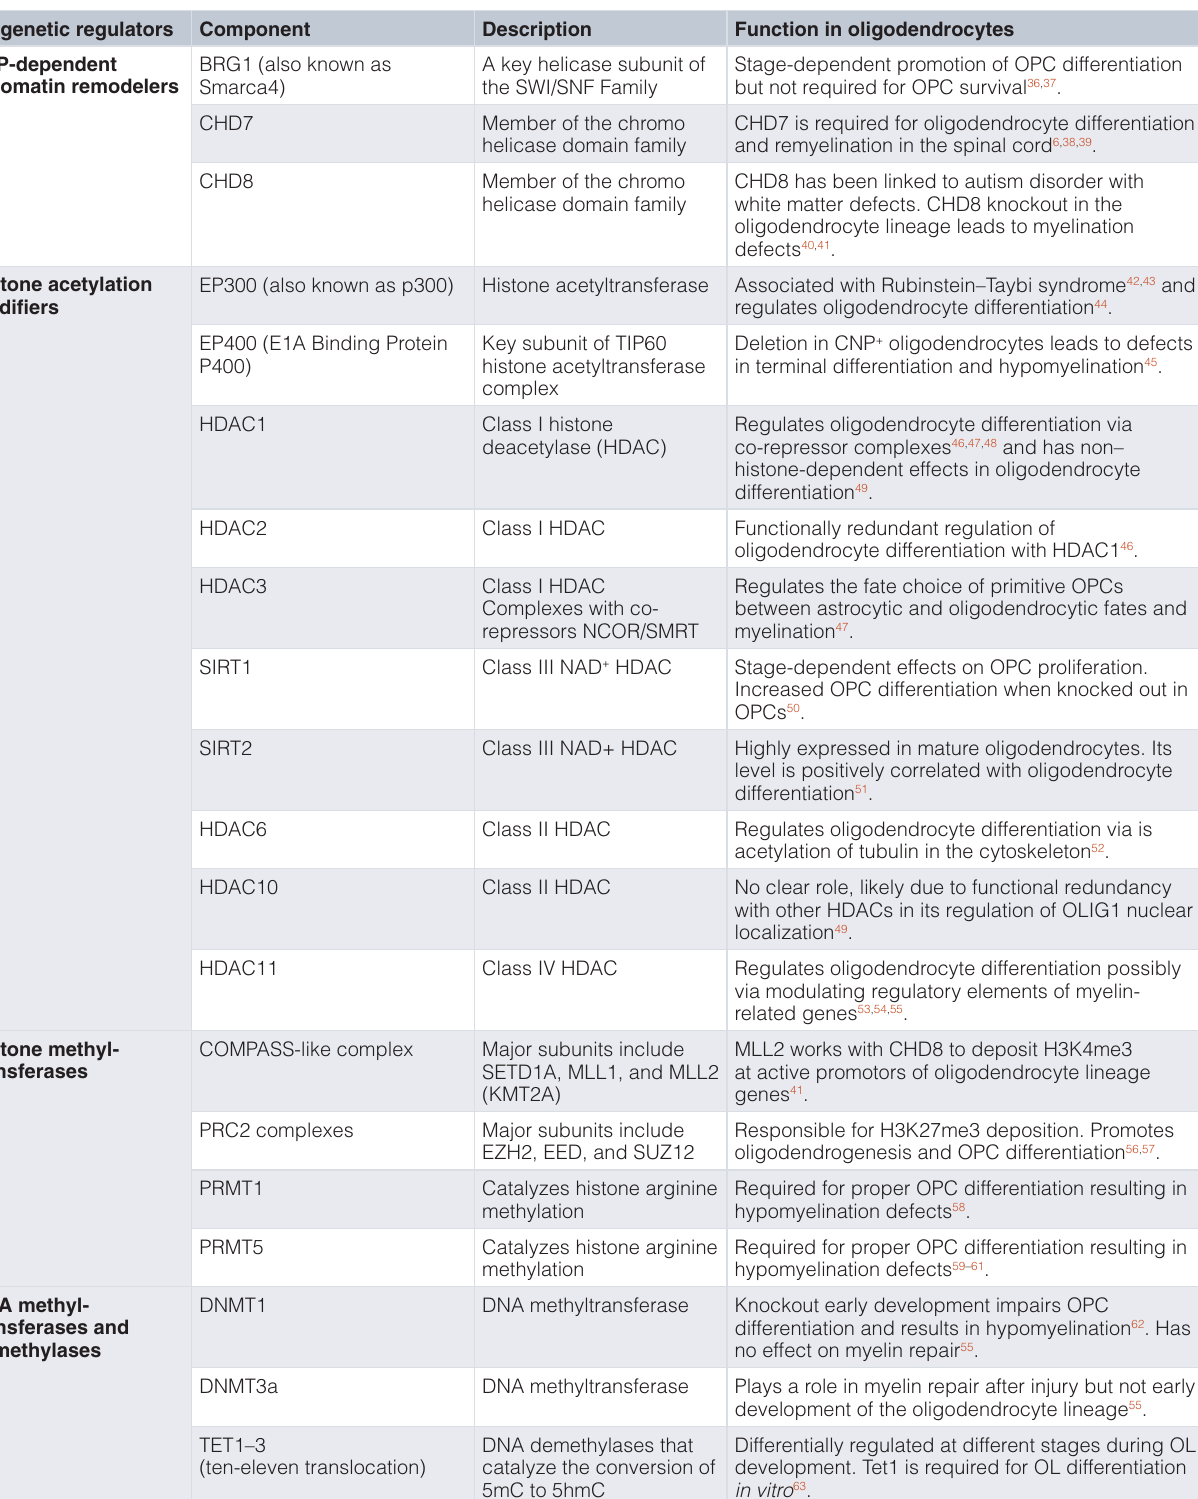
Table 1. Epigenetic pathways in oligodendrocyte development and